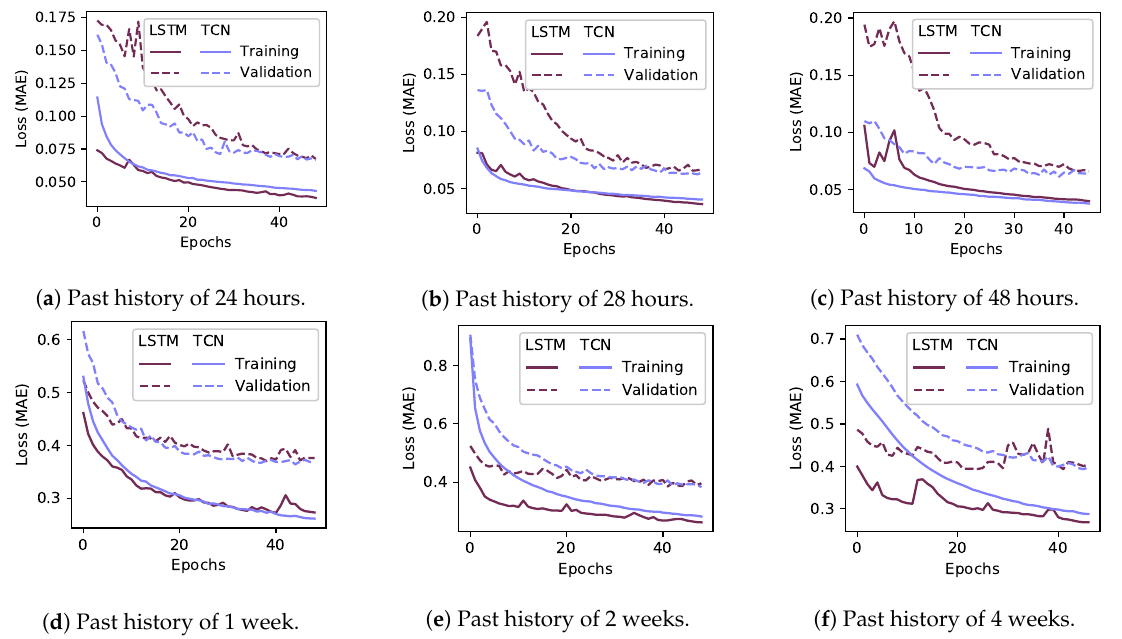
Figure 8. Evolution of the training and validation loss function of the best TCN and LSTM models for each possible value of past history. First row corresponds to the electric demand data ( a – c ), while the second row corresponds to the EV power consumption data ( d – f